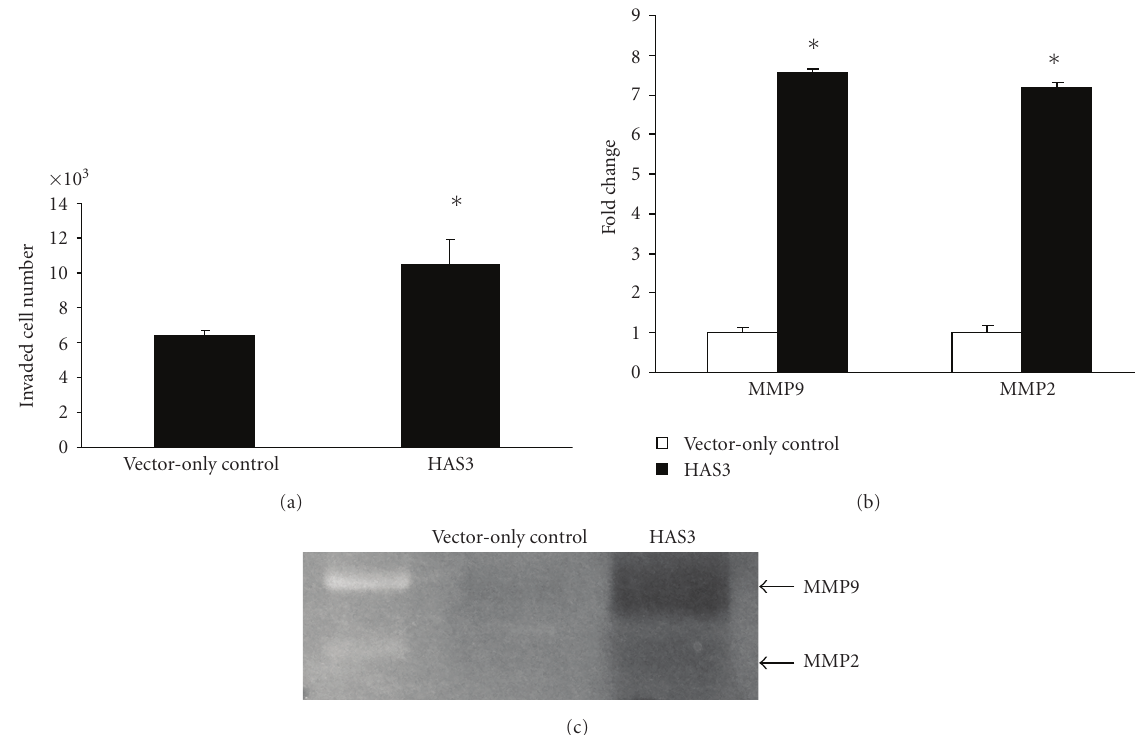
Figure 4: Increased HA production promotes cell invasion and induces enhanced MMP2 and MMP9 activities in H358 cells. (a) Invasive capacity of HAS3 and vector—only control transfectants were determined using invasion chamber assay (BD Bioscience) as outlined in Material and Method. (b) mRNA expression for MMP2 and MMP9 were determined by quantitative real time RT-PCR. (c) Following 48 hours incubation in serum-free media, media was collected and gelatinase activities for MMP2 and MMP9 were assayed by gelatin zymography. The experiments were repeated twice. The data shown for (a) and (b) is a representative. (Values are mean ± SD, n = 3, ∗ P < .